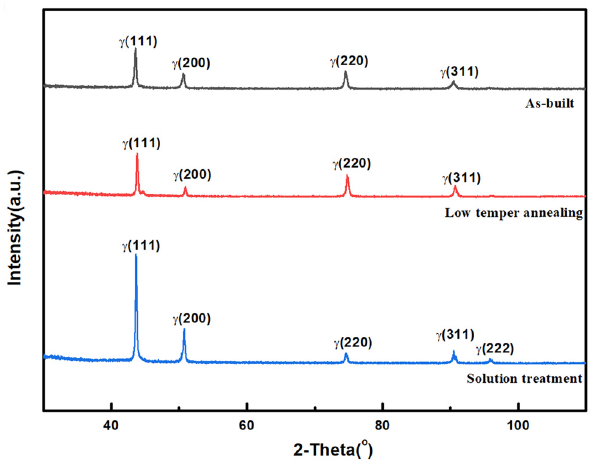
Figure 5: XRD diagrams of samples under di ff erent heat treatment